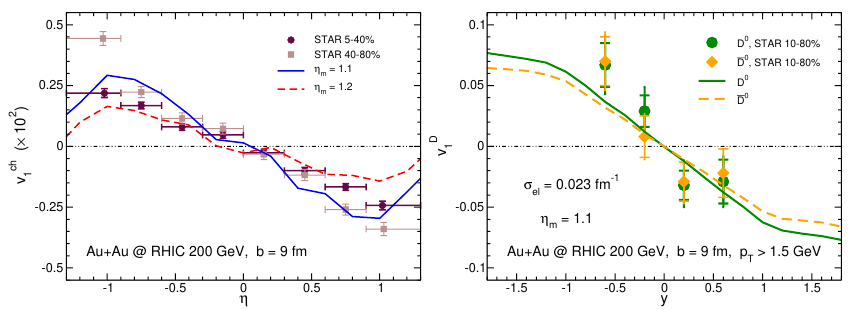
Figure 1. (Pseudo)rapidity dependence of the directed flow of charged particles (left) and D mesons (right) in Au + Au collisions at RHIC energy √ s NN = 200 GeV with impact parameter b = 9 fm. The experimental data are from the STAR Collaboration [18, 19]. Figures from Ref. [5].